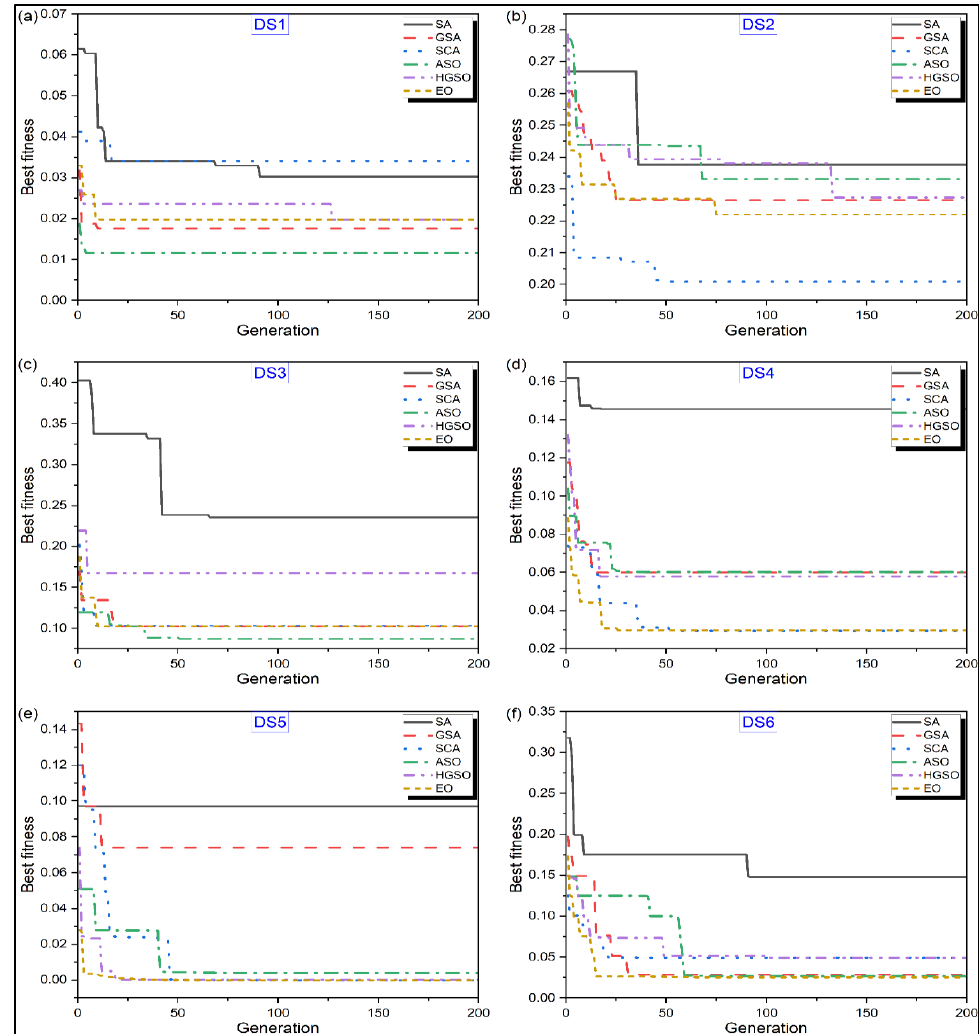
Figure 4. Convergence curves of all algorithms on all selected datasets i.e., ( a ) Breast cancer (DS1) dataset, ( b ) German (DS2) dataset, ( c ) Heart (DS3) dataset, ( d ) Ionosphere (DS4) dataset, ( e ) Ovarian cancer (DS5) dataset, ( f ) Sonar (DS6) dataset.